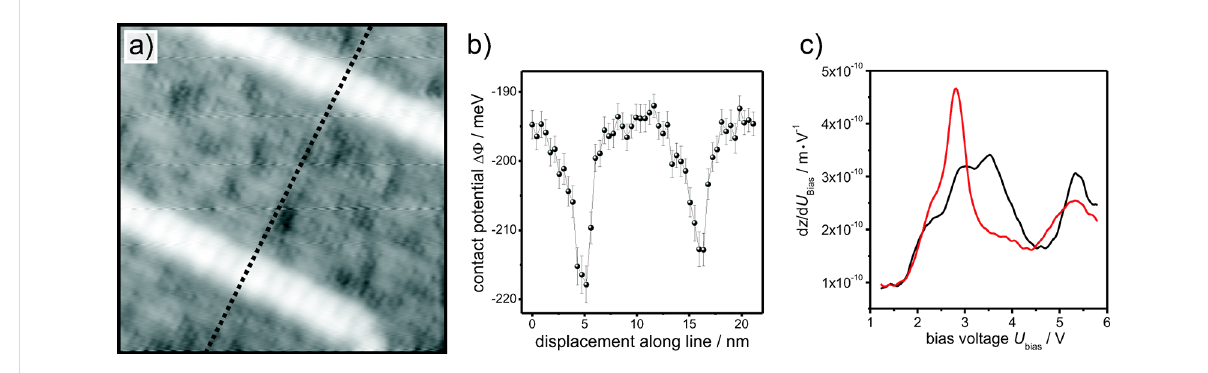
Figure 12: Spectroscopy on aluminum oxide. a) STM image of a thin fi lm of aluminum oxide on NiAl(110), 18 nm × 18 nm. Two straight APDBs (bright) separating three A domains (dark) are visible. U bias = +3 V and I t = 100 pA. b) Effective contact potential, which was determined at the line shown in (a), decreases at the APDB by approximately 20 meV. The tip height was constant during the measurement and corresponds to a frequency shift of − 1 Hz at − 150 mV. The contact potentials were determined by fi tting the frequency shift vs bias voltage curves with a quadratic term (see Equation 5). The error bars represent the accuracies by which the maxima were determined. c) STS curves taken at the domain (black) and the APDB (red).